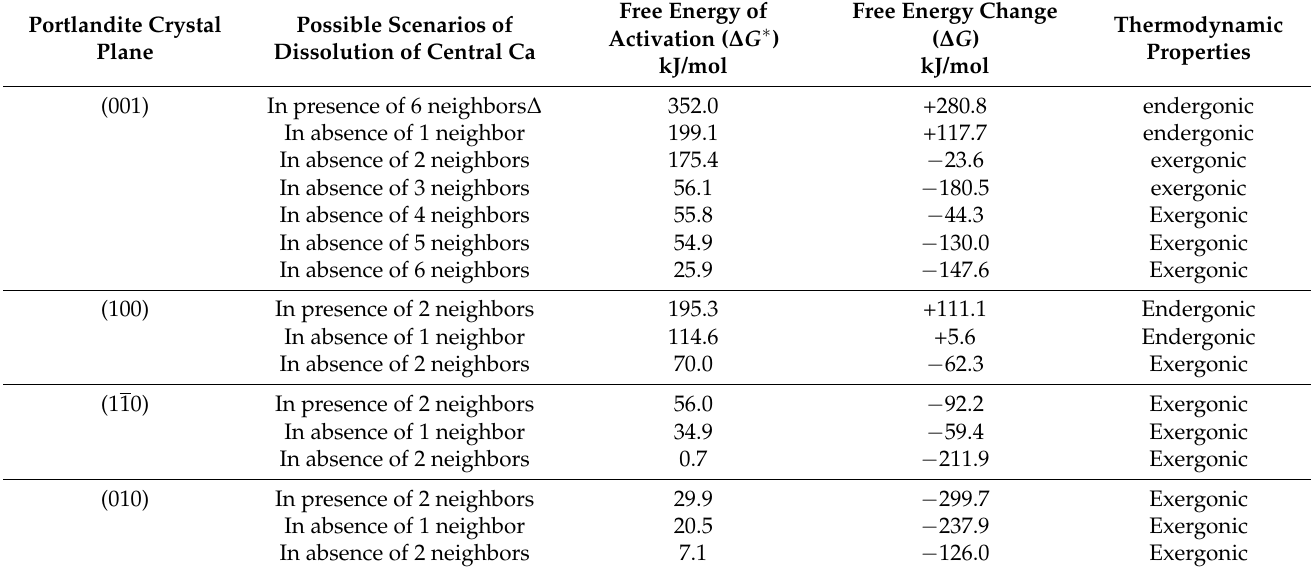
Table 1. Free energy change of different facets of Portlandite during the dissolution of calcium at standard ambient temperature (298 K) and pressure (101.325